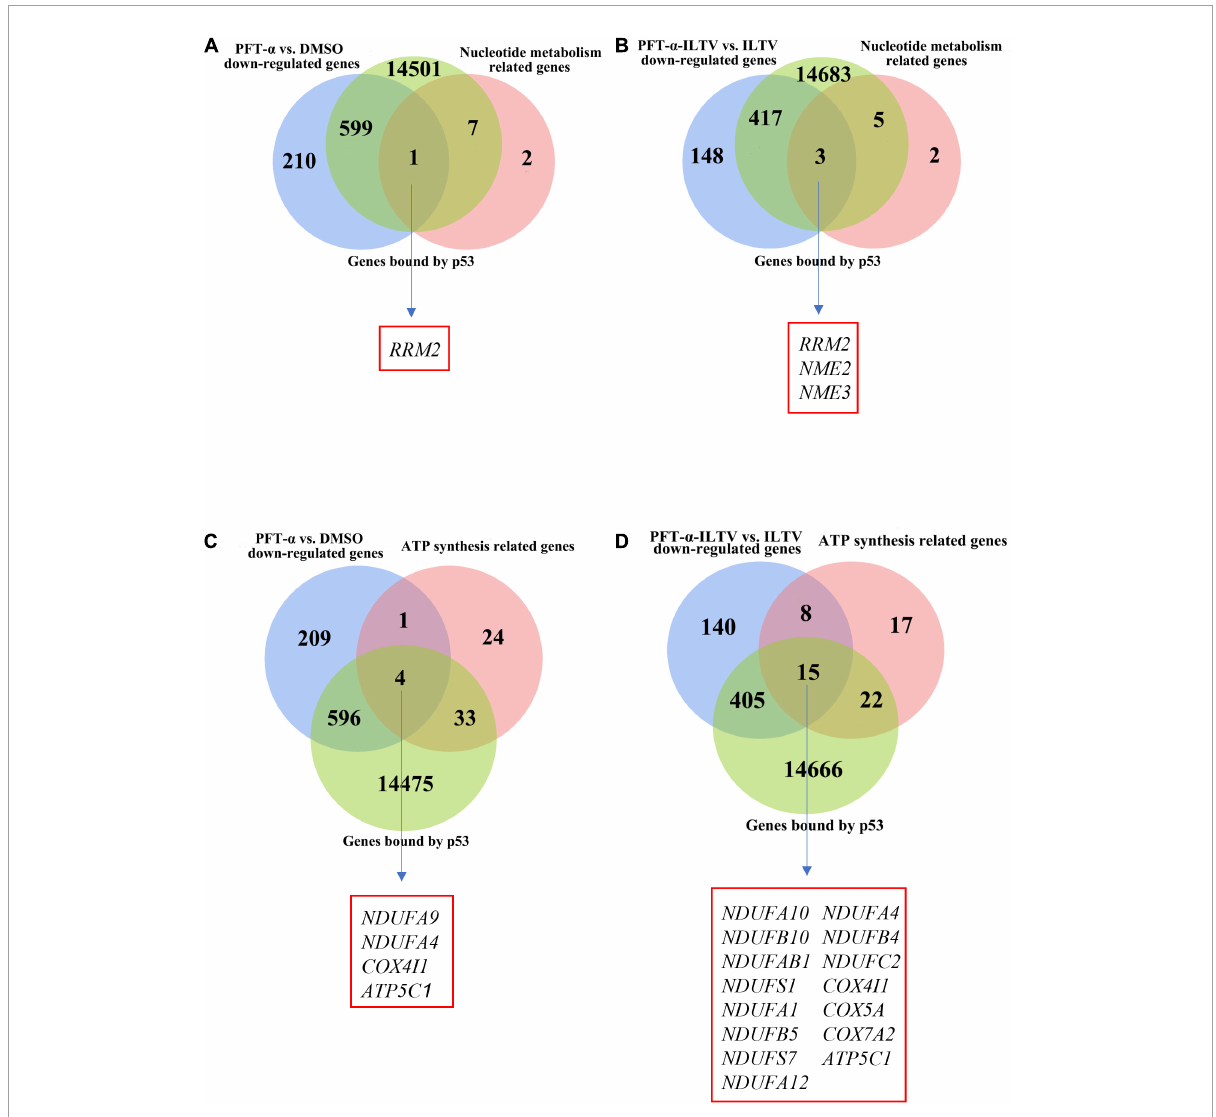
FIGURE4 Relationship between genes bound by p53 and key nucleotide metabolizing or ATP synthesis related enzyme genes. (A) Venn diagram showing the intersections of these DEGs ( p- value < 0.05) of the administration of PFT- α , nucleotide metabolism related genes and genes bound by p53. (B) Venn diagram showing the intersections of these DEGs ( p- value < 0.05) of the administration of PFT- α in ILTV-infected cells, nucleotide metabolism related genes and genes bound by p53. (C) Venn diagram showing the intersections of these DEGs ( p- value < 0.05) of the administration of PFT- α , ATP synthesis related genes and genes bound by p53. (D) Venn diagram showing the intersections of these DEGs ( p- value < 0.05) of the administration of PFT- α in ILTV-infected cells, ATP synthesis related genes and genes bound by